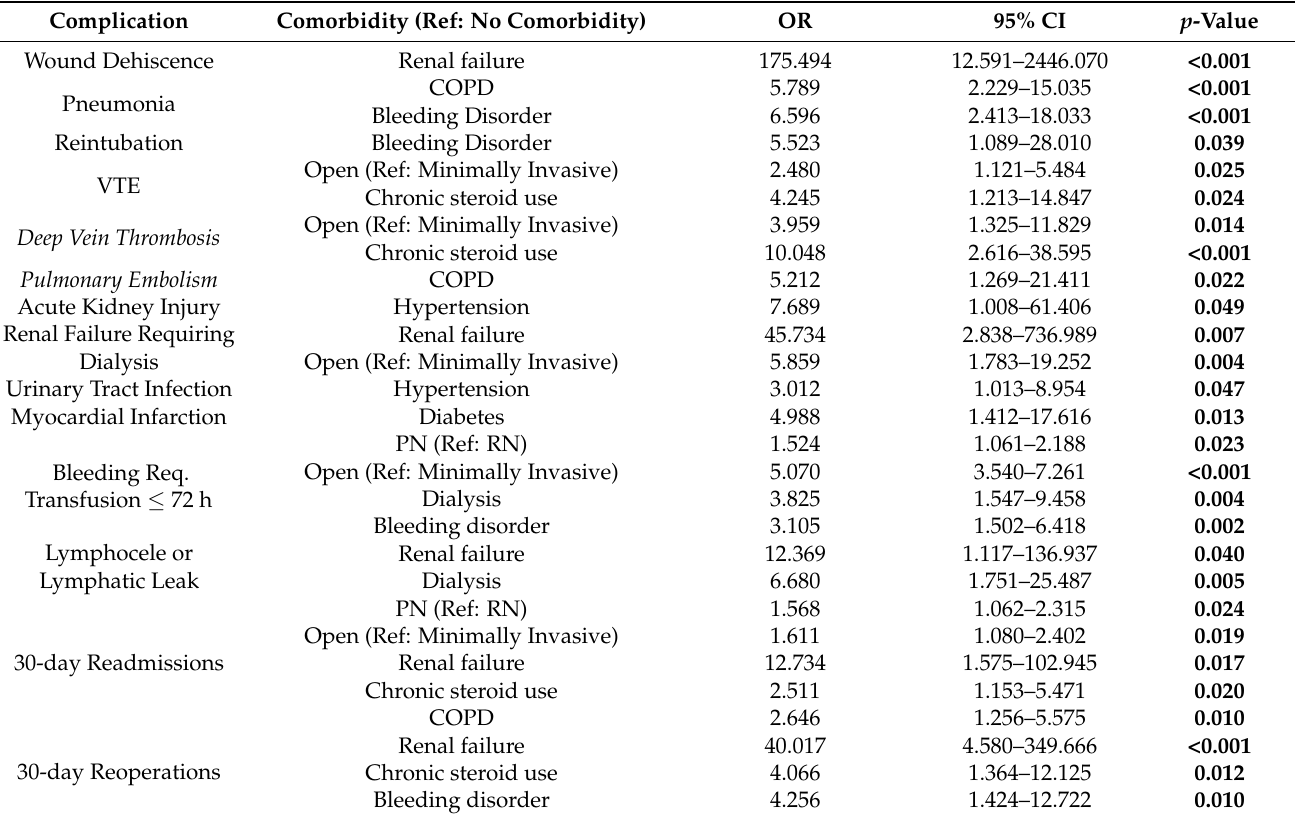
(Table 4). MVA was repeated for the PN and RN cohorts separately to further clarify risk factors (Supplementary Tables S2 and S3). Table 3. Significant associations between patient co-morbidities and peri-operative complications on univariate analysis.